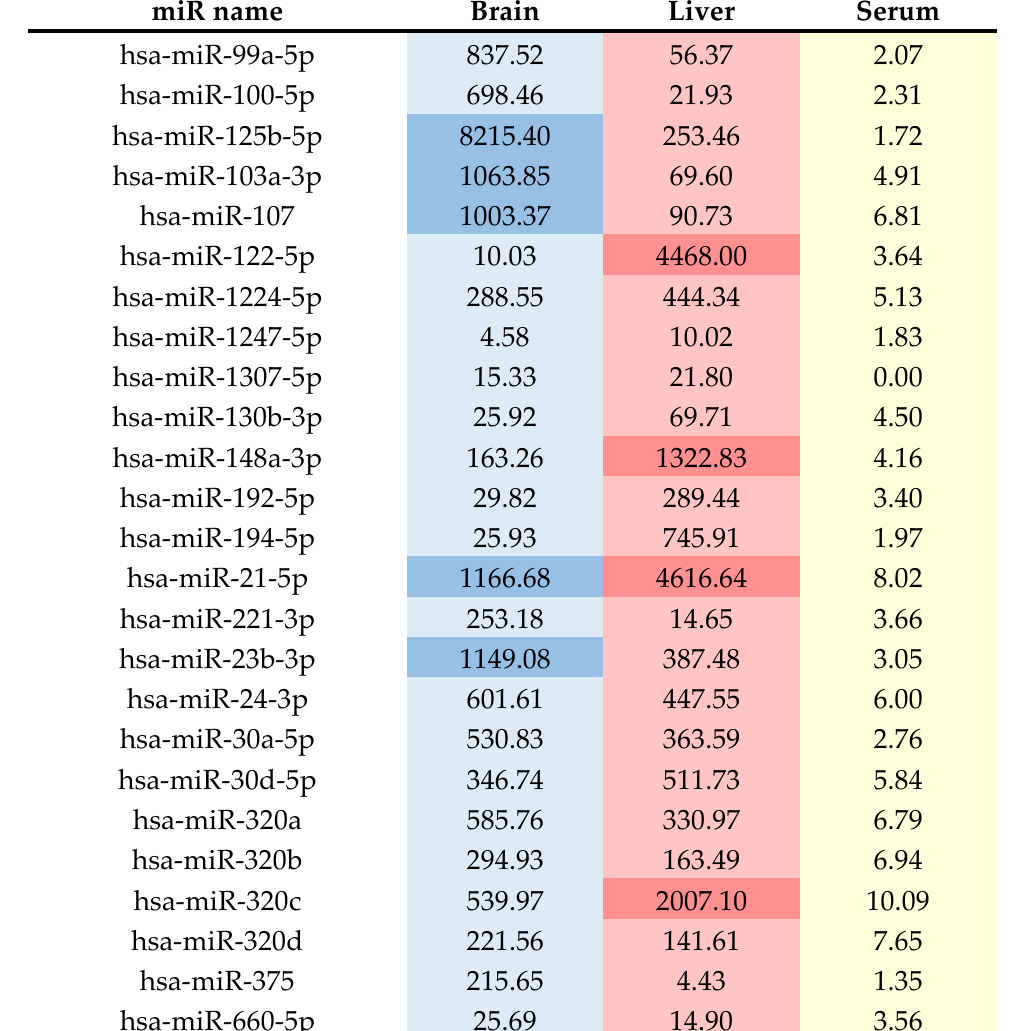
Figure 4. Normalized miRNA expression level in the normal human brain, liver, and serum analyzed by Human miRNATissueAtlas of miRNAs expression. MiRNAs with distinctive high expression are highlighted.